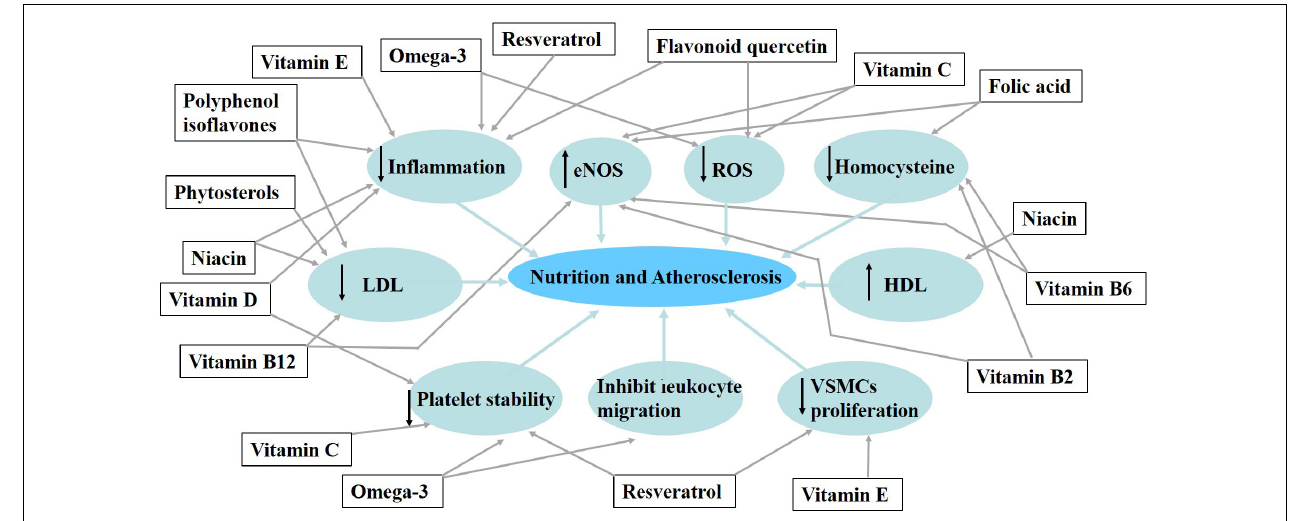
FIGURE 1 | The influence of some nutrients and bioactive compounds on the process of